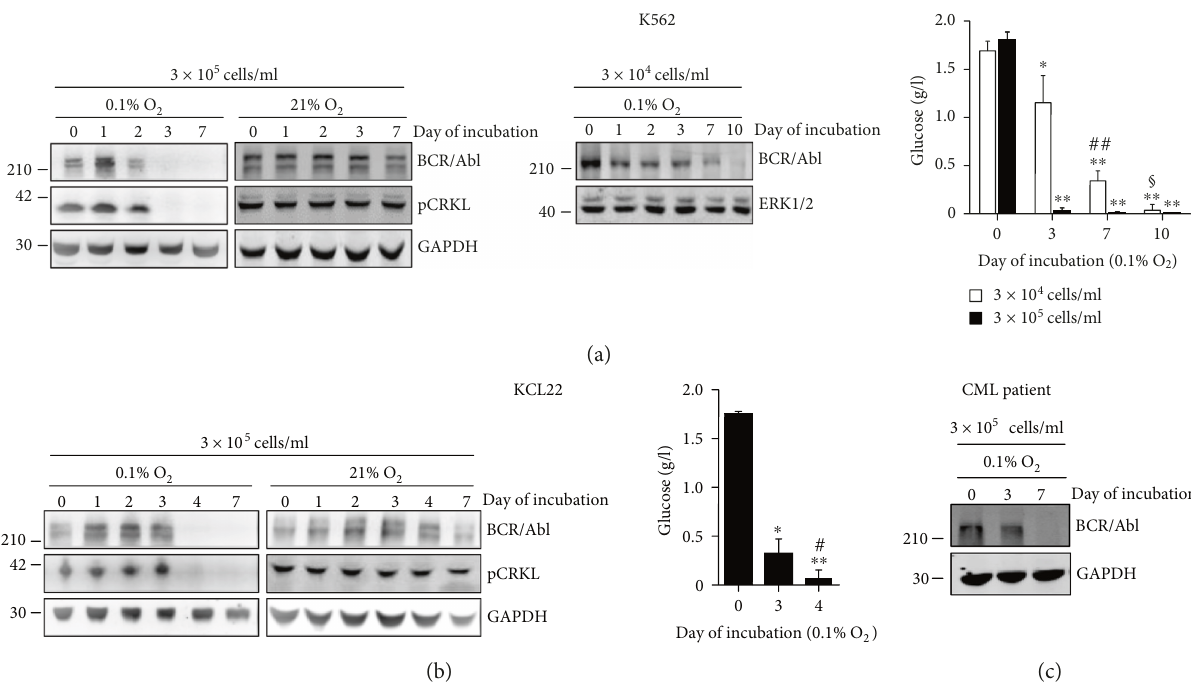
Figure 1: Suppression of BCR/Abl protein in CML cells undergoing “ adaptation to hypoxia. ” K562 cells (a), KCL22 cells (b), or blast-crisis primary cells (c) were plated at the indicated time-zero cell concentrations and incubated in atmosphere at 0.1% or 21% O obtained at the indicated incubation times were immunoblotted using anti-c-Abl (detecting BCR/Abl) or anti-phospho-CRKL antibodies or, as loading equalization control, anti-GAPDH or anti-ERK1/2 antibodies; migration of molecular weight markers is indicated on the left (kDa). One out of three independent experiments with similar outcome is shown. Glucose concentration in the medium of cultures incubated at 0.1% O was measured at the indicated incubation times as described in Materials and Methods. Values are means ± SD 2 of data from 3 independent experiments; ∗ p ≤ 0 05 and ∗∗ p ≤ 0 01 versus time 0; # p ≤ 0 05 and ## p ≤ 0 01 versus day 3; § p ≤ 0 01 versus day